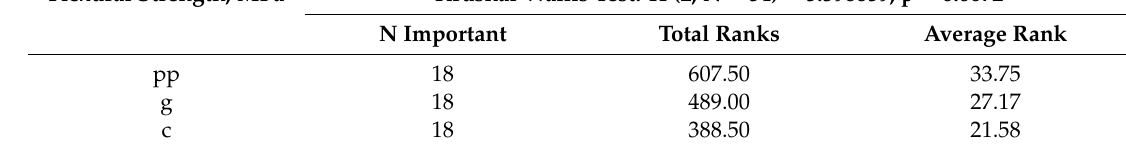
Table 5. Results of the Kruskal-Wallis ANOVA rank test for flexural strength related to the type of fibres.